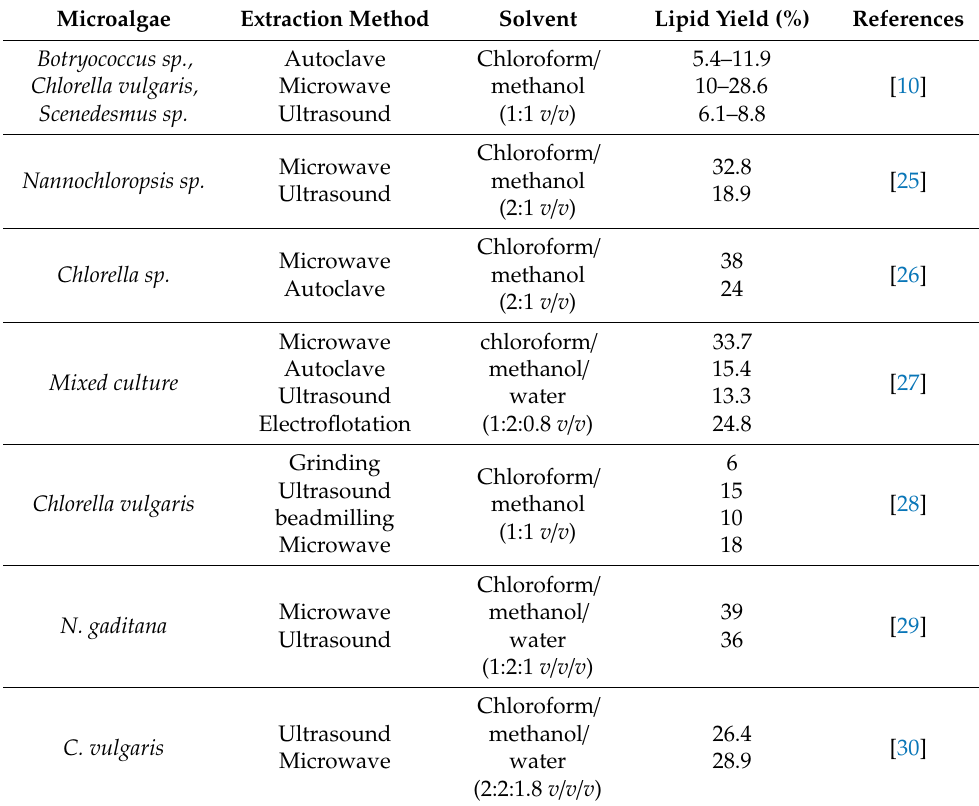
Table 2. Summarization of recent studies that comparing microwave-assisted extraction (MAE) with other non-conventional methods for lipid extraction yield from di ff erent microalgal species.